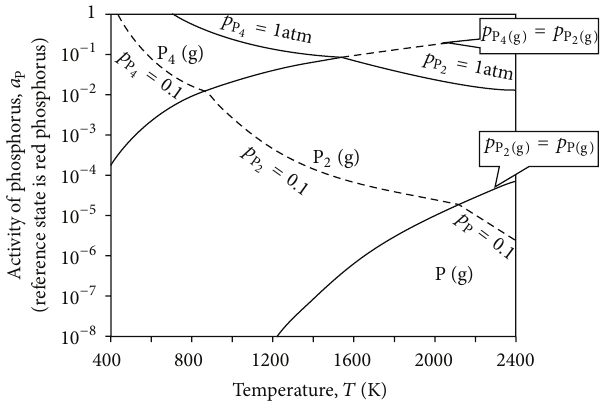
Figure2:Estimationofpredominantgaseousspeciesinequilibrium [12]. Reference state of phosphorus activity is red phosphorus.